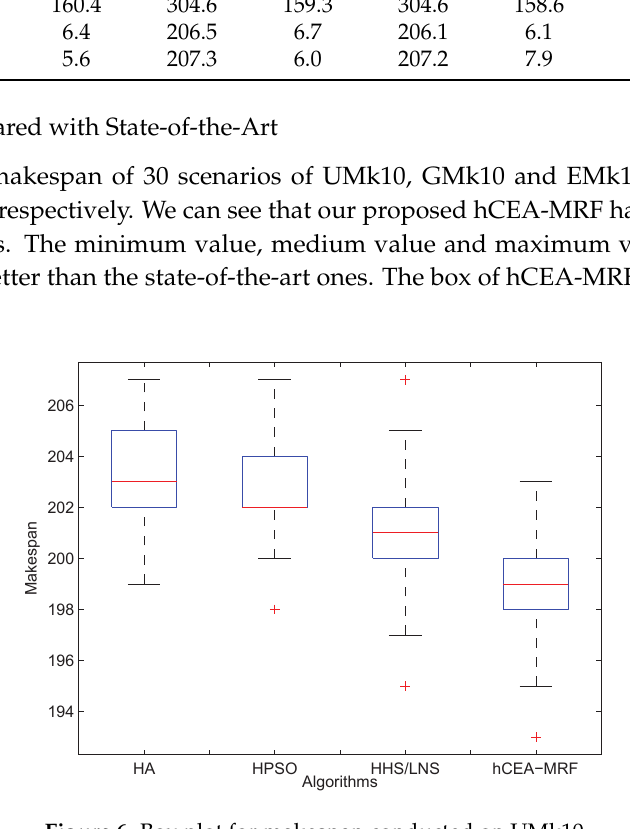
Figure 6. Box plot for makespan conducted on UMk10.